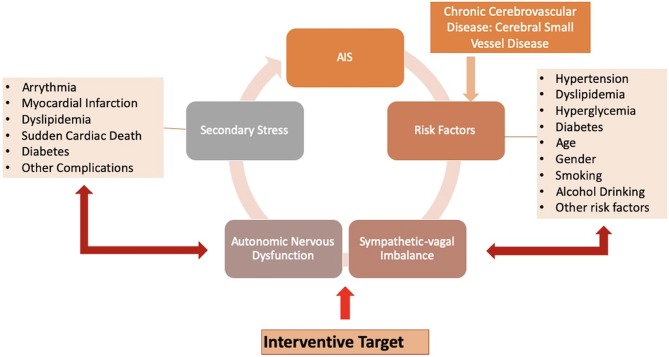
Hypertension, diabetes, smoking, and other risk factors of stroke, as well as acute ischemic stroke (AIS) and cerebral small vessel disease (CSVD), may have a negative influence on the body. Regulated by the autonomic nervous system (ANS), the body initiates the stress response to these various stressors perceived by the brain, in an attempt to neutralize the effects of the stressors and regain homeostasis. When demands for re-establishment exceed the adaptive capacity, impaired ANS attributed to altered sympathetic-vagal balance may provide inaccurate responses or progressively lead to a delayed reactivity. This eventually evolves into stress-related disorders as secondary stresses, such as arrhythmia, myocardial infarction, dyslipidemia, and other complications. These secondary stressors increase the incidence of recurrent ischemic stroke. These pathways can form a vicious cycle, while targeting sympathetic-vagal imbalance maybe an efficient interventional strategy.